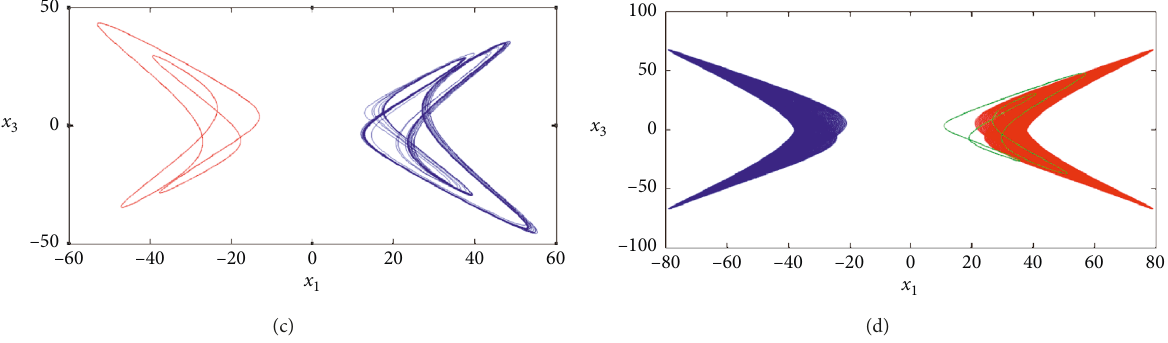
Figure 5: Symmetric coexisting attractors for parameters: (a) d � 9 and the initial conditions are [ 0 . 1 , ± 0 . 1 , 0 . 1 , 0 . 1 , 0 . 1 ] (red and blue), (b) d � 12 . 5 and the initial conditions are [ 0 . 1 , − 0 . 1 , 0 . 1 , 0 . 1 , 0 . 1 ] and [− 0 . 1 , 0 . 1 , 0 . 1 , 0 . 1 , 0 . 1 ] (red and blue), (c) d � 9 and the initial conditions are [ 0 . 1 , − 0 . 1 , 0 . 1 , 0 . 1 , 0 . 1 ] and [ 2 , 1 , 1 , 2 , 2 ] (red and blue), and (d) d � 11 . 9 and the initial conditions are [−